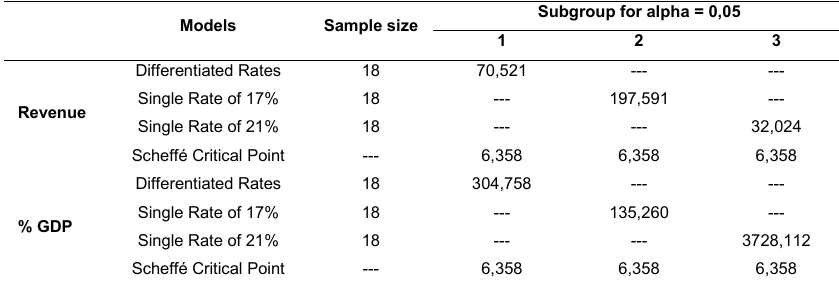
Table 3. Results of the Scheffé test. Source: Own elaboration. Note: The size of the categories is equal. The harmonic mean of the category size (18,000) is